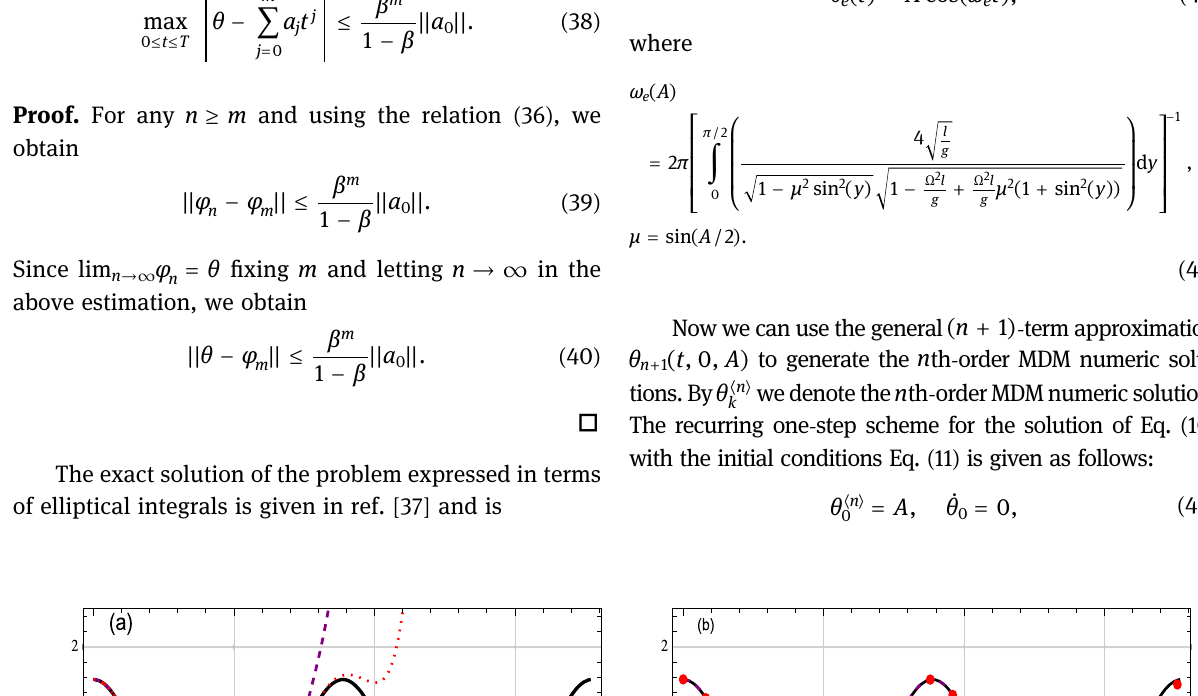
25 ⟨ ⟩ with step - size h 0.3 = ( dots ) . ( c ) Absolute error when we compare θ k